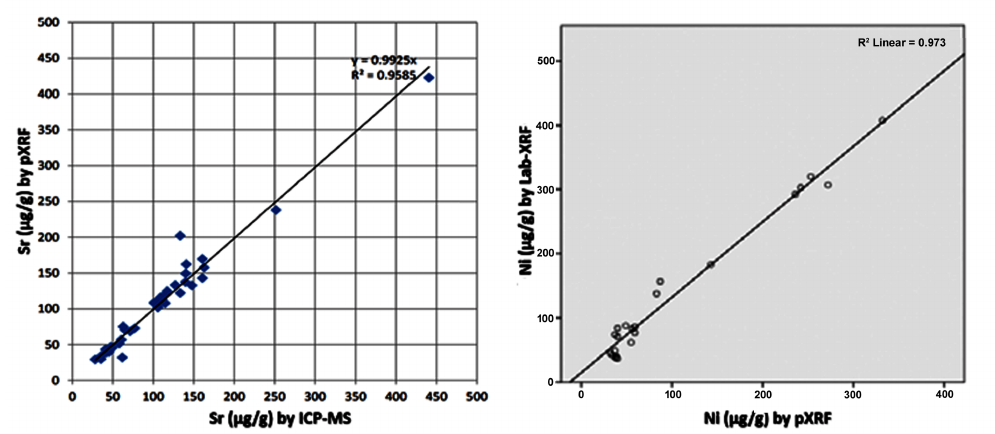
Figure 1. Favorable correlation between the data of strontium in a sandstone obtained by pXRF onsite in the field and by ICP-MS in a laboratory and Ni by pXRF in the field and XRF in a laboratory